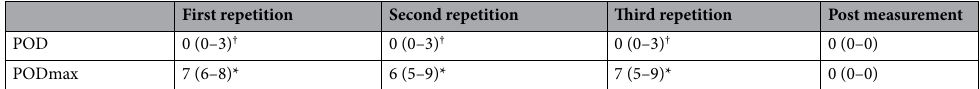
Table 2. NRS during jack-knife stretching and POST measurement. Data were represented as median (interquartile range). *p < 0.01 vs. values in post measurement at PODmax. † p < 0.01 vs. values at PODmax in the same stretching